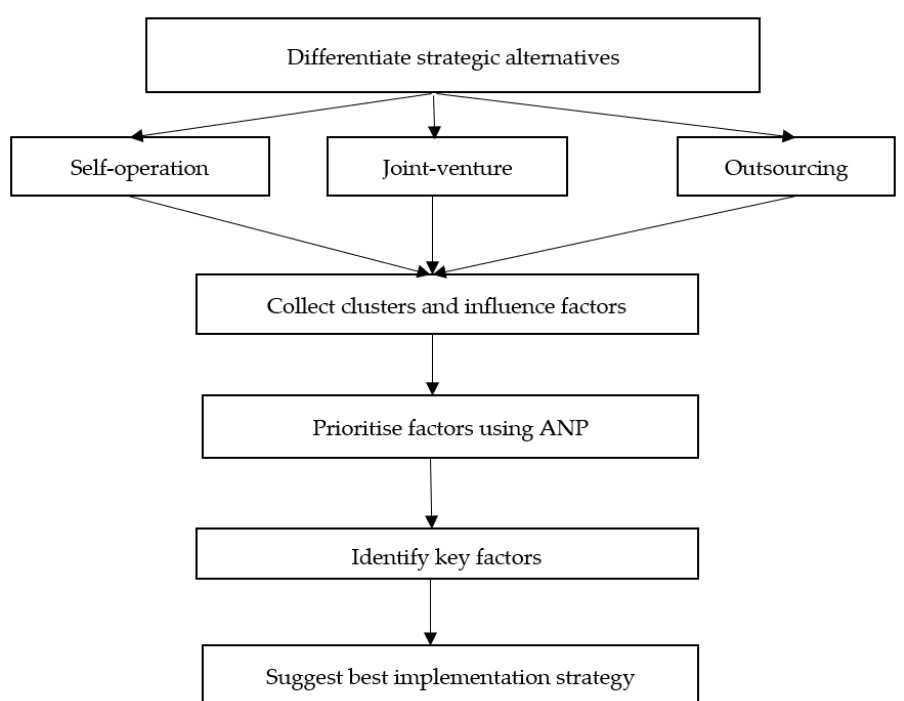
Figure 1. Framework for identifying the best RL strategy.